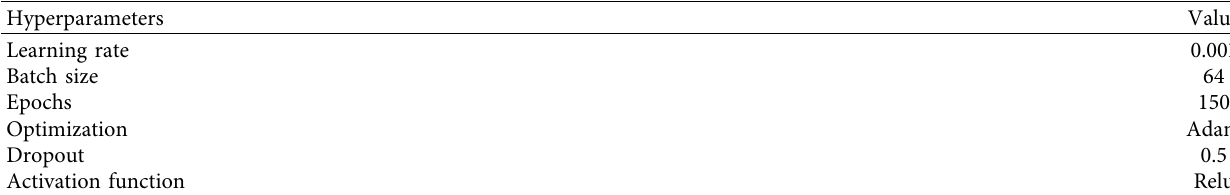
Table 1: The hyperparameters settings.